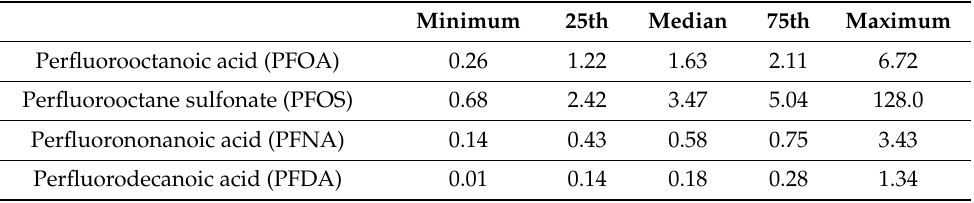
Table 2. Descriptive statistics of perfluoroalkyl (PFAS) concentrations in blood of study participants (ng/mL).